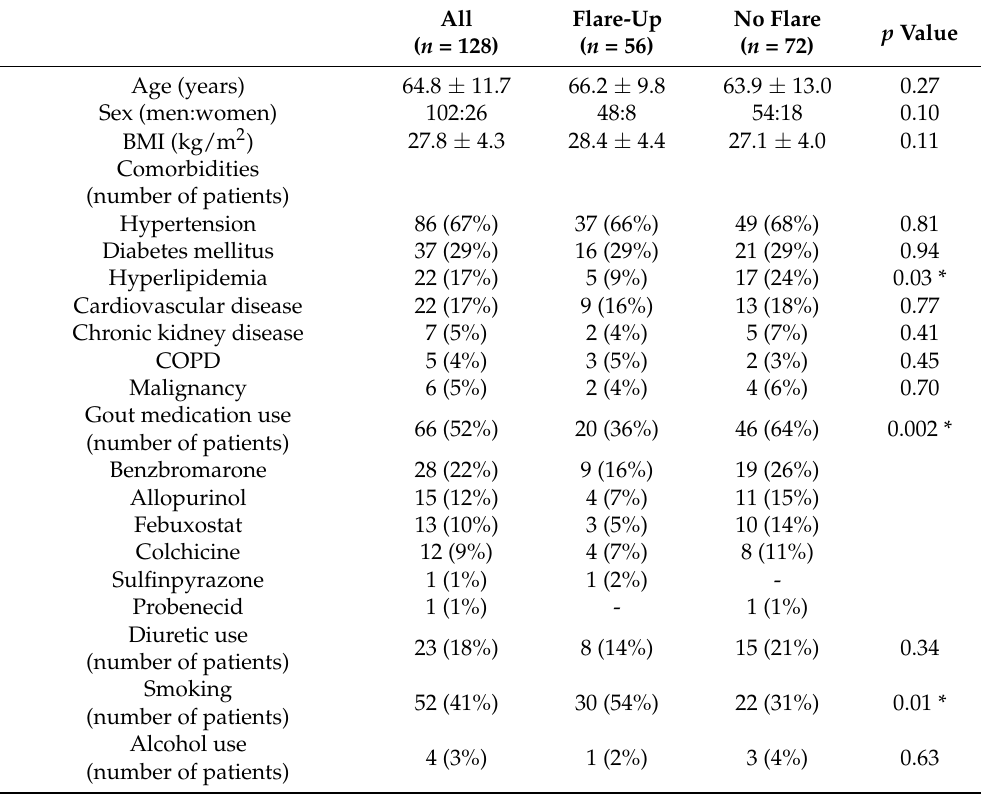
Table 1. Demographic characteristics of